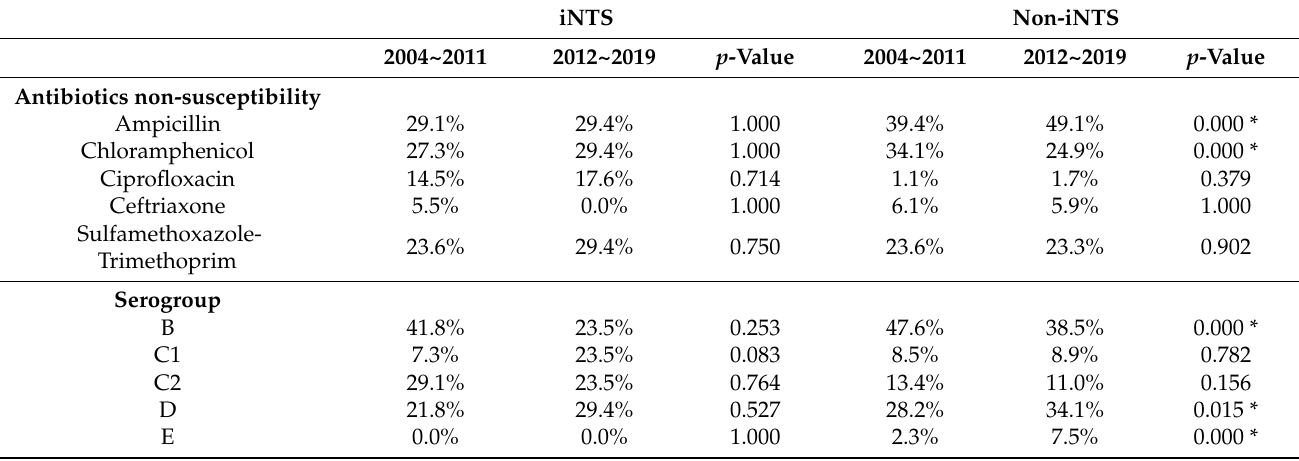
Table 3. Antibiotics non-susceptibility rate and serogroups between iNTS and non-iNTS.